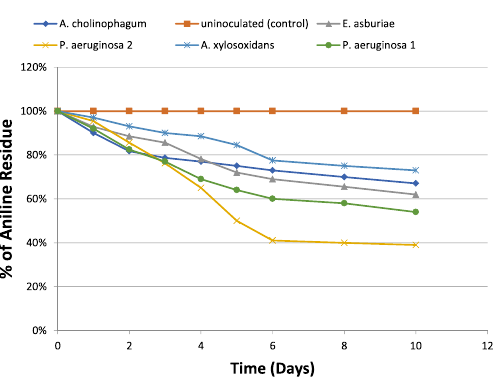
five isolates in MSM containing aniline (f&) at a concentration of 100 mg /l in MSM using aniline as the sole carbon and energy source, and uninoculated (control) (%).